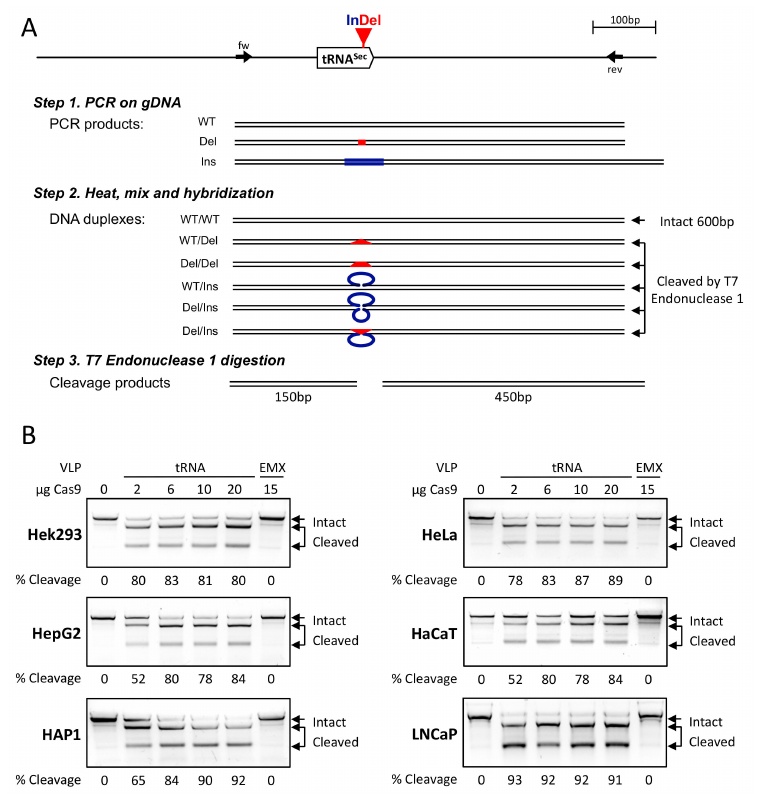
Figure 3. Evaluation of tRNA [Ser]Sec gene editing activities by CRISPR-Cas9-VLPs used in various cell lines with T7 endonuclease 1 mismatch assay. ( A ) Illustration of this assay applied to detect Cas9 induced mutations. The gDNA was extracted from cells treated with Cas9-sgRNA and used for a polymerase chain reaction (PCR) amplification of the tRNA [Ser]Sec gene using forward (fw) and reverse (rev) primers. The PCR product (fragment of approximately 600 bp) is composed of a mixture between the original wild-type (WT) and the Cas9 induced mutated sequences. The deletions (Del) and insertions (Ins) are represented in red and blue, respectively. The PCR products were heated, mixed and re-hybridized before addition of the T7 endonuclease 1, which cuts when heteroduplexes are formed during annealing (i.e., WT / Del, Del / Del, WT / Ins, Del / Ins and Del / Ins). The size of the digestion products were 150 and 450 bp. ( B ) The six di ff erent cell lines were treated with increasing amount CRISPR-Cas9-VLPs, targeting either tRNA [Ser]Sec or EMX gene. Four days post-treatment, the cells were harvested, and their gDNA was analyzed with T7 endonuclease 1 assay. An aliquot of the reaction was run on an 2.5% agarose gel. The cleavage e ffi ciency of the PCR fragment was calculated as the percentage of cleaved products relative to all fragments in each lane. The positions of the intact and cleaved DNAs are indicated by